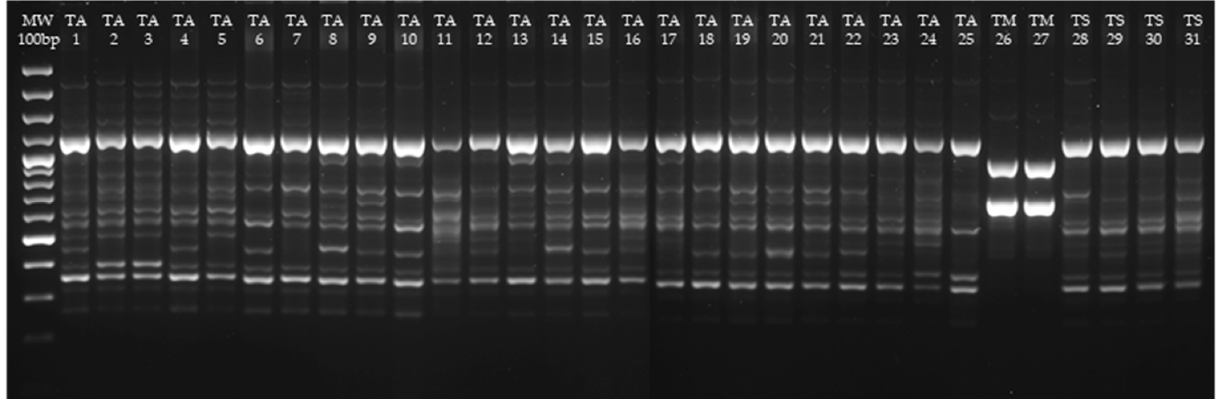
Figure 1. DNA migration pattern of the ISSR marker (UBC808) for all 31 samples of Triticum (2% agarose gel, migration for 130 min, 70 V).